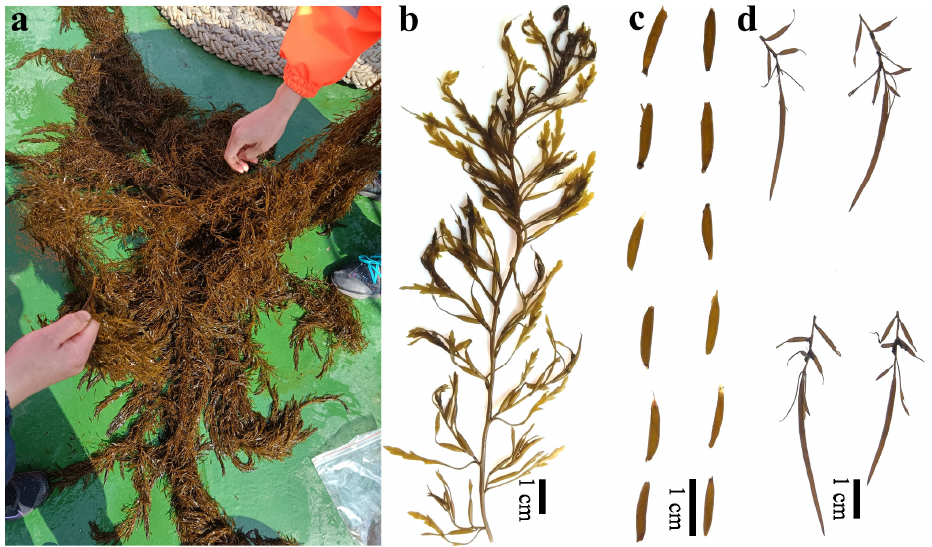
Figure 2. ( a ) Morphology of Sargassum thalli collected in the Southern Yellow Sea; ( b ) Blades; ( c ) Gas bladders; ( d ) Receptacles.